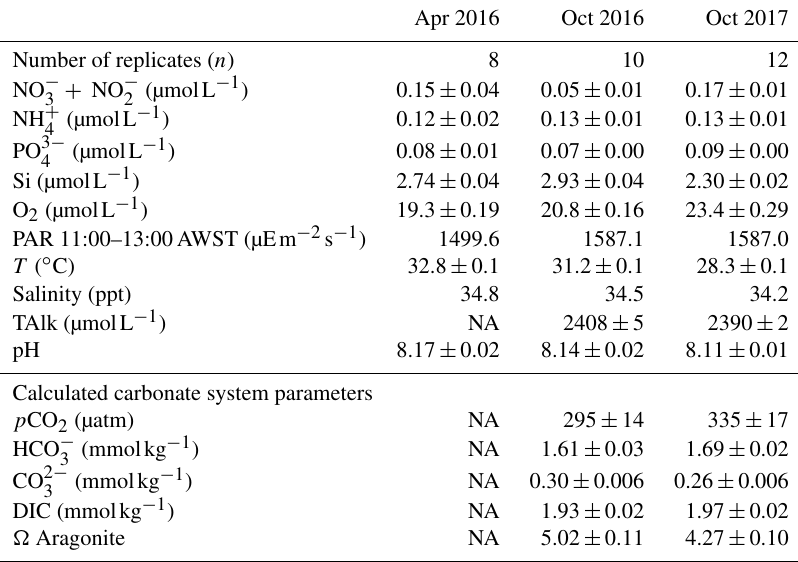
Table 2. Ambient concentrations of parameters measured during incubations (mean ± SE): nutrients (NO − = ammonium, PO 3 − = orthophosphate, Si = silica) and oxygen (O NH + 4 4 temperature ( T ) and salinity. Calculated carbonate system parameters (mean ± SE): CO 2 partial pressure ( p CO 2 ), concentrations of HCO − CO 2 − and dissolved inorganic carbon (DIC) and the saturation state of aragonite ( (cid:127) Aragonite). In April 2016, two replicate PAR mea- 3 surements were taken at 11:00, 12:00 and 13:00AWST (Australian Western Standard Time). In October 2016 and 2017, PAR was measured every minute and values between 11:00 and 13:00